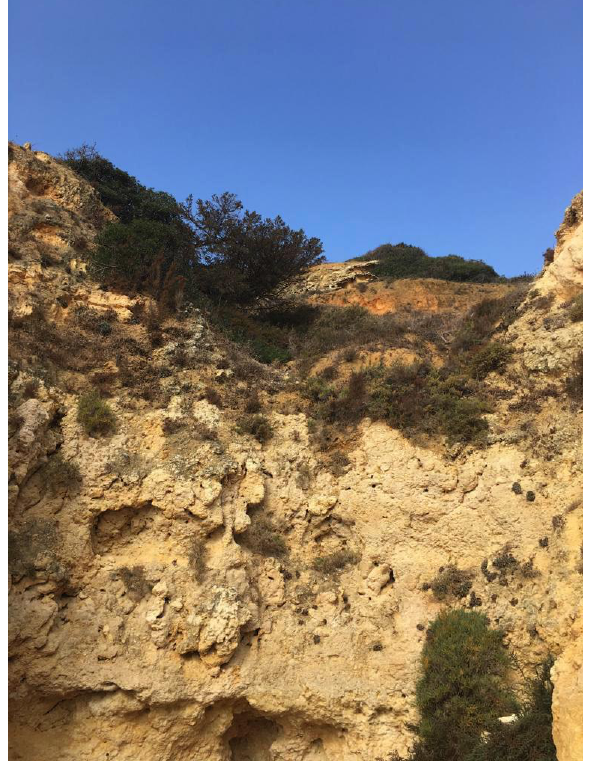
Figure 5. Overlapping carbonate strata and clastic sediments.